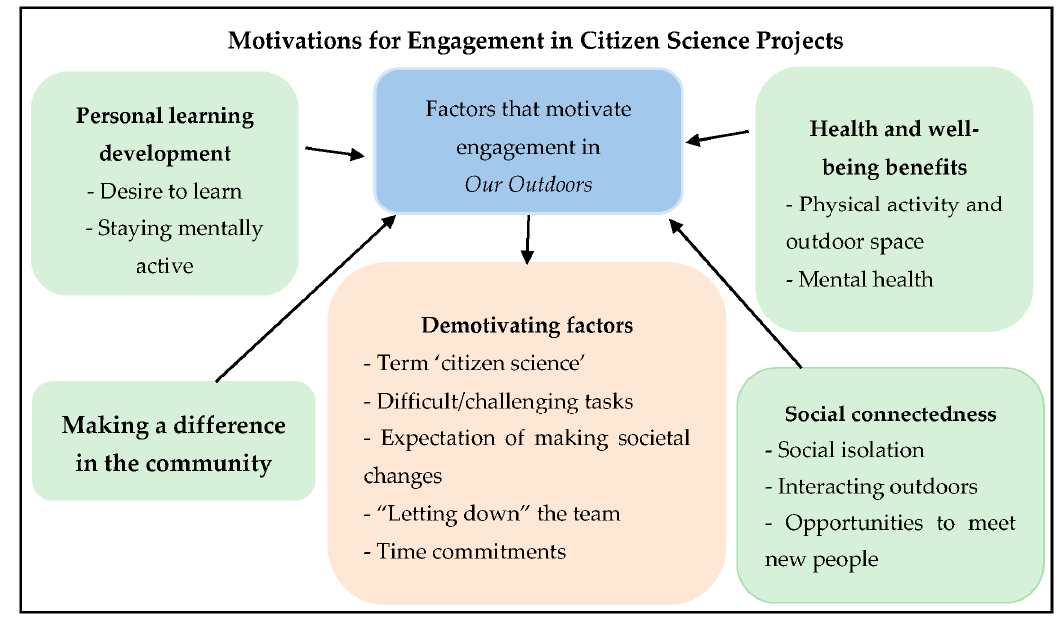
Figure 1. Motivations for Engagement in Citizen Science Projects—visual depiction of the findings.